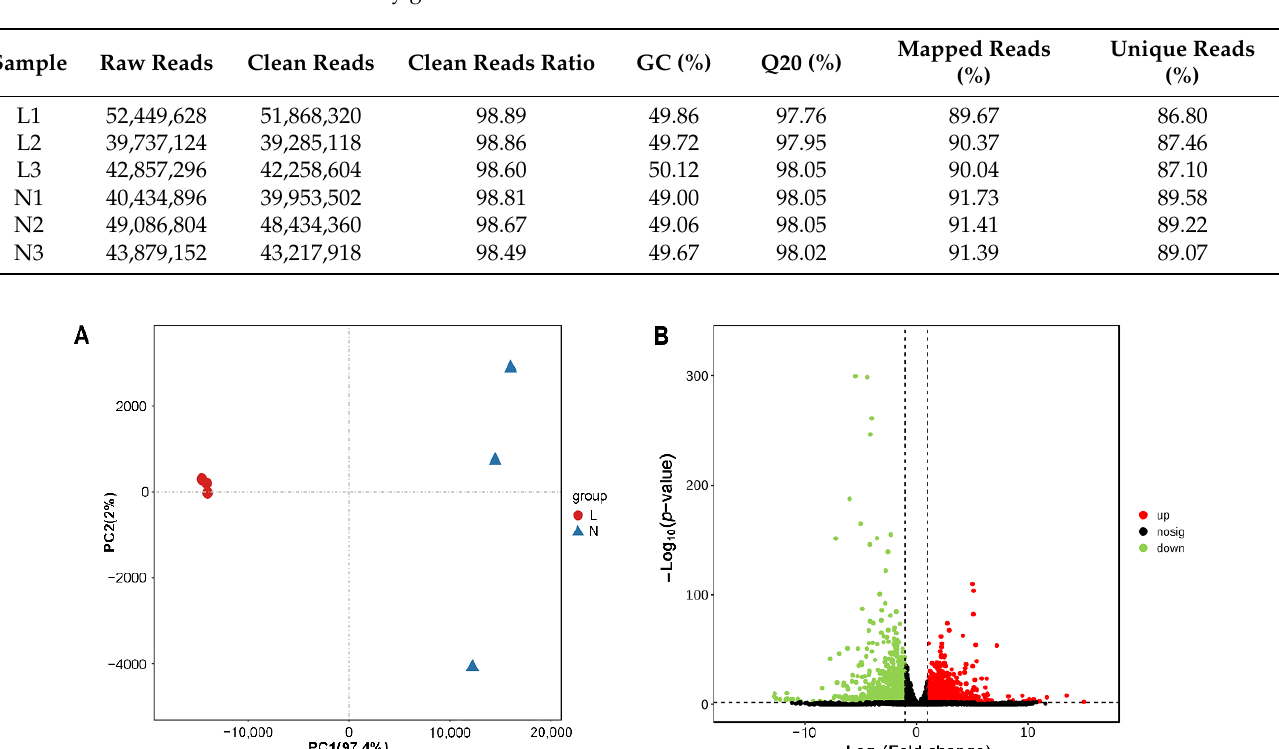
Table 1. Overview of the reads and quality control of the mRNA sequencing libraries from jenny mammary glands.